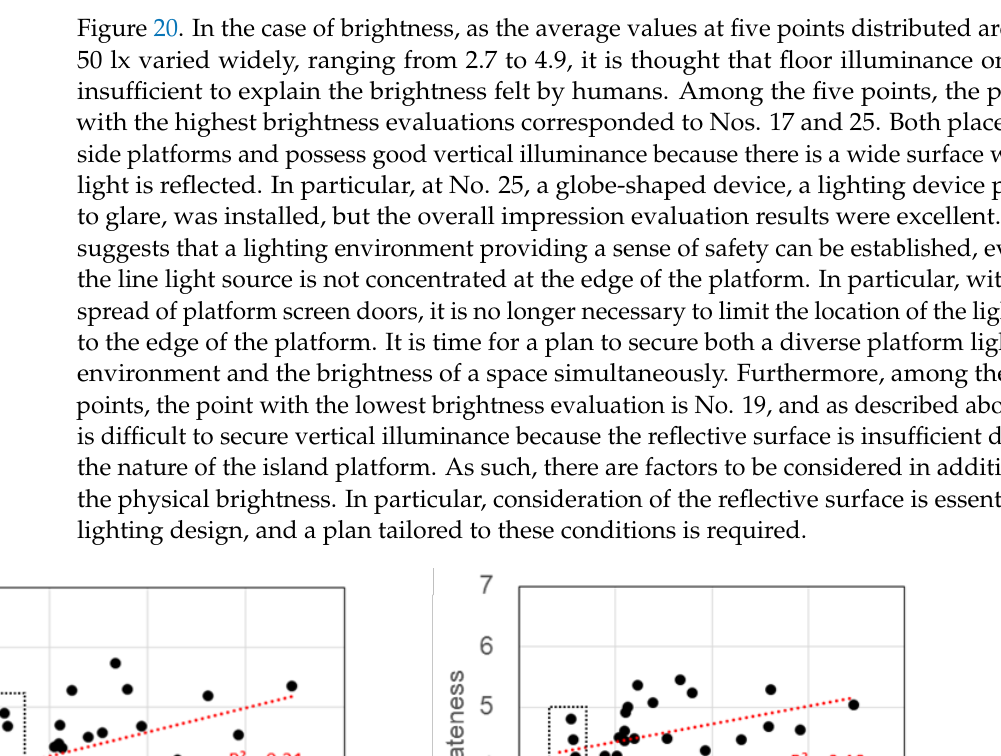
Figure 20. Relationship between floor illuminance and impressions.